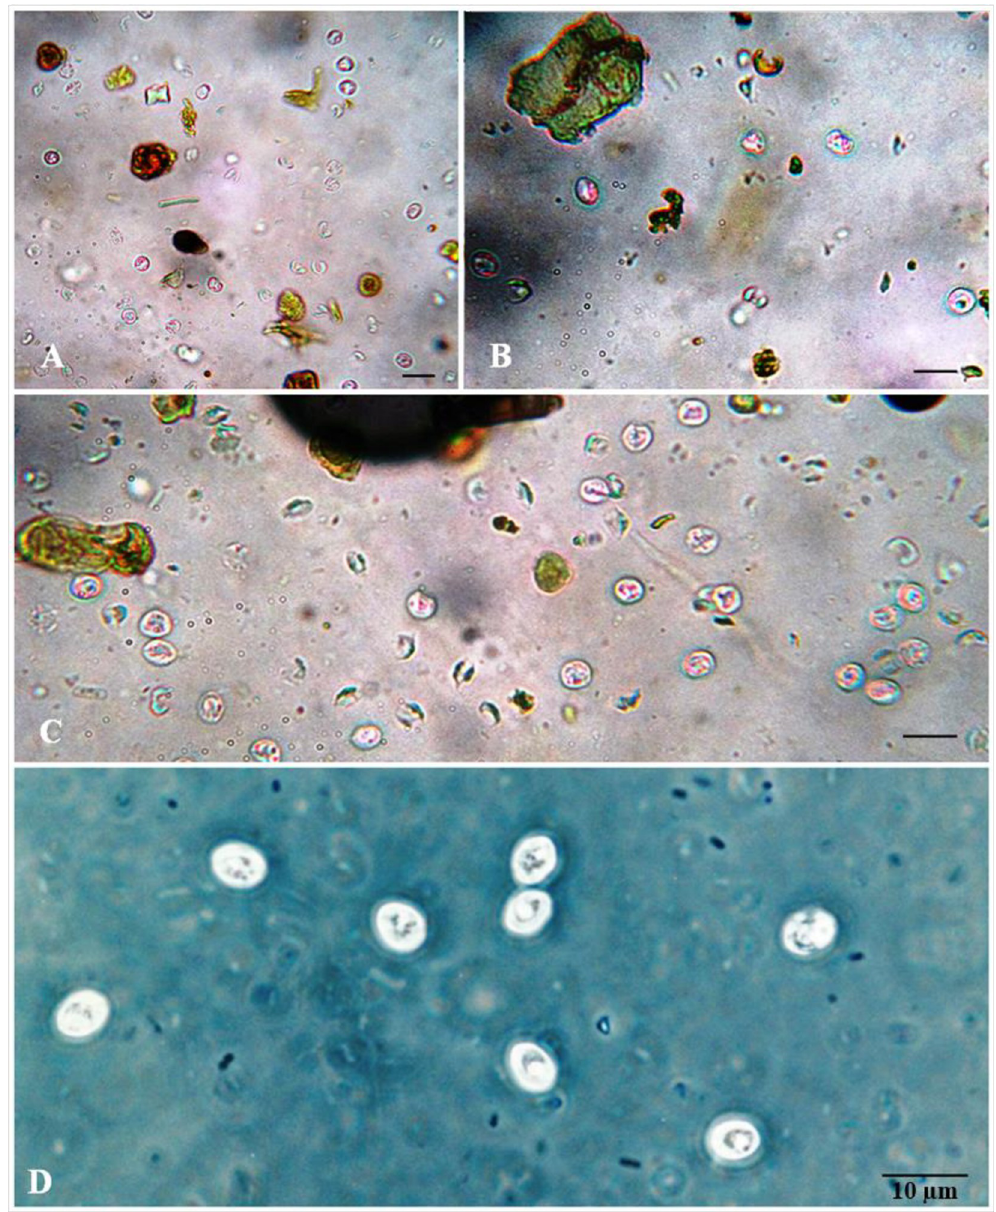
Fig 2. Cryptosporidium spp. oocysts from fecal samples of dogs and cats in the Campo Grande neighborhood, Rio de Janeiro, Brazil. A, B, and C: oocysts observed under bright-field microscope; D: oocysts observed under phase-contrast